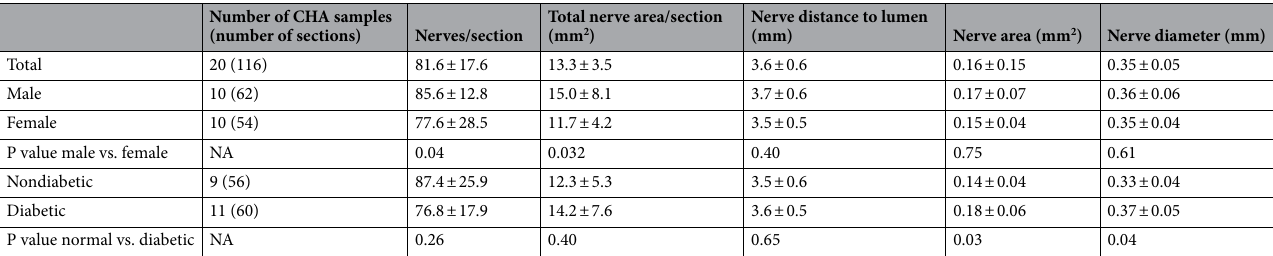
Table 2. CHA associated nerve parameters classified by sex and diabetic status. Values are n or mean ± SD. Student t test with unequal variances or Mann–Whitney test as